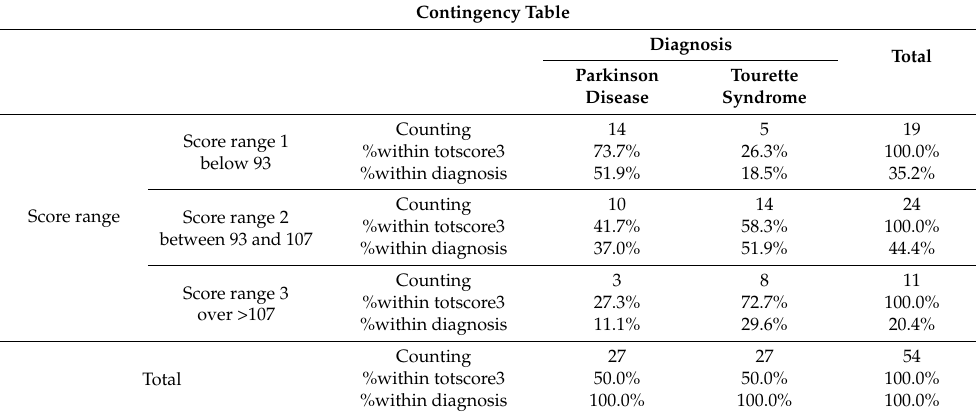
Table 7. Results of the sample in score